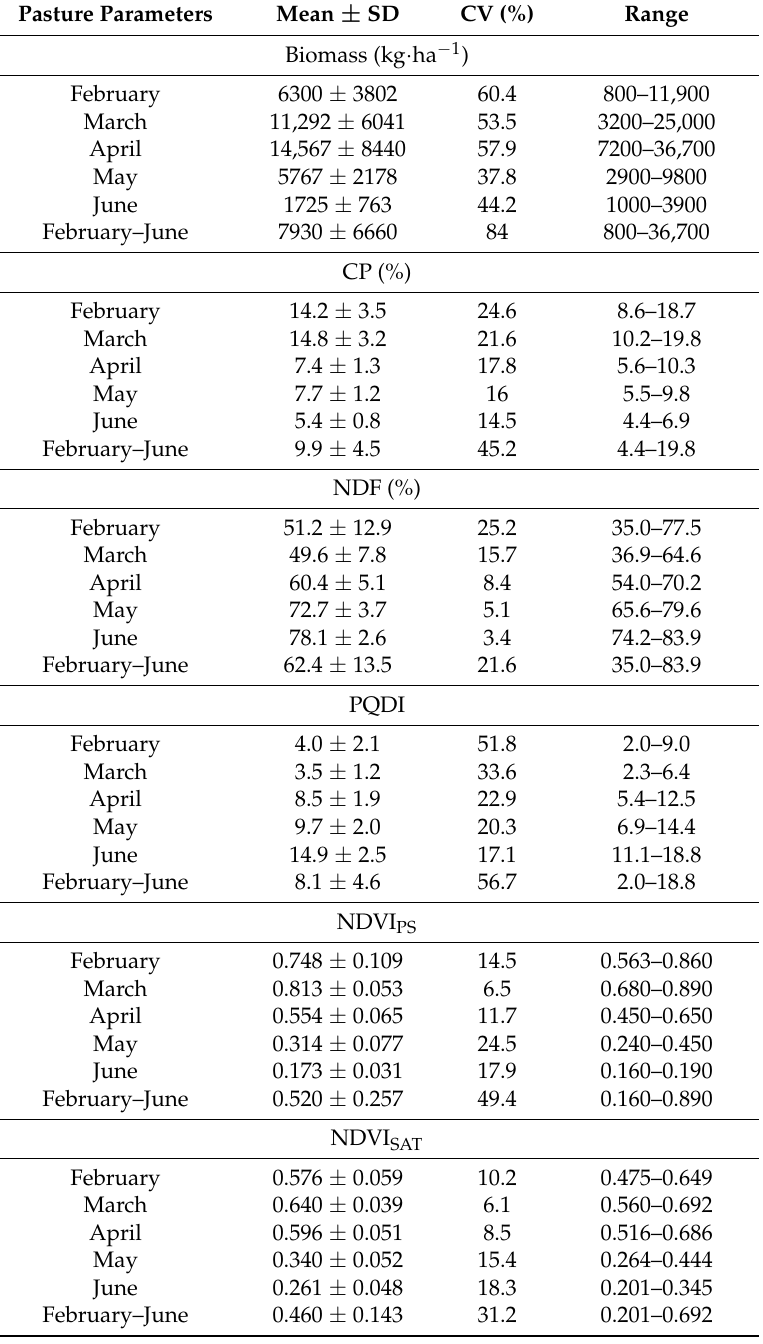
Table 1. Descriptive statistics of pasture parameters, measured at the twelve sampling points of the studied field, for each sampling date and for the total period considered (between February and June